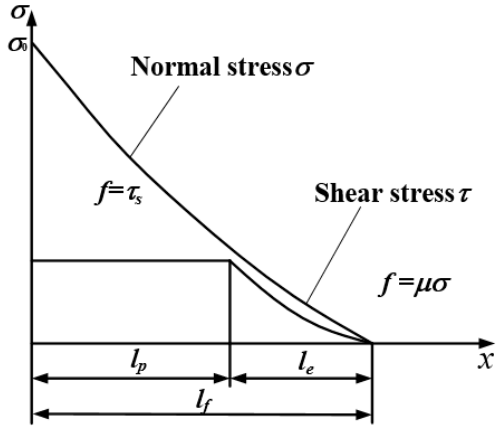
Figure 7. Stress model of the contact